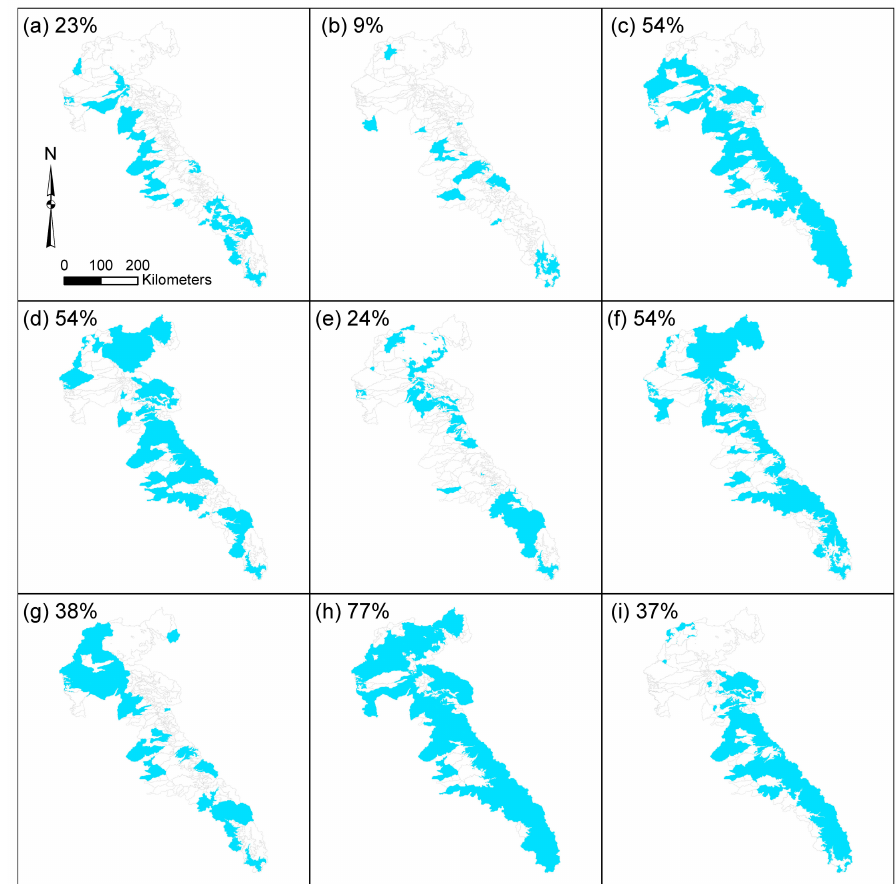
Figure 5. Study basins (highlighted in blue) with significantly (at a significance level of 0.05) different probability distributions in two different sub-periods of the study period for temperature indices ( a ) TX10, ( b ) TX90, ( c ) TN10, ( d ) TN90, ( e ) TX6h, ( f ) TN6h, ( g ) TXM, ( h ) TNM, and ( i ) DTR. Percentage numbers show how much the aggregated area of those basins accounts for the entire study area.